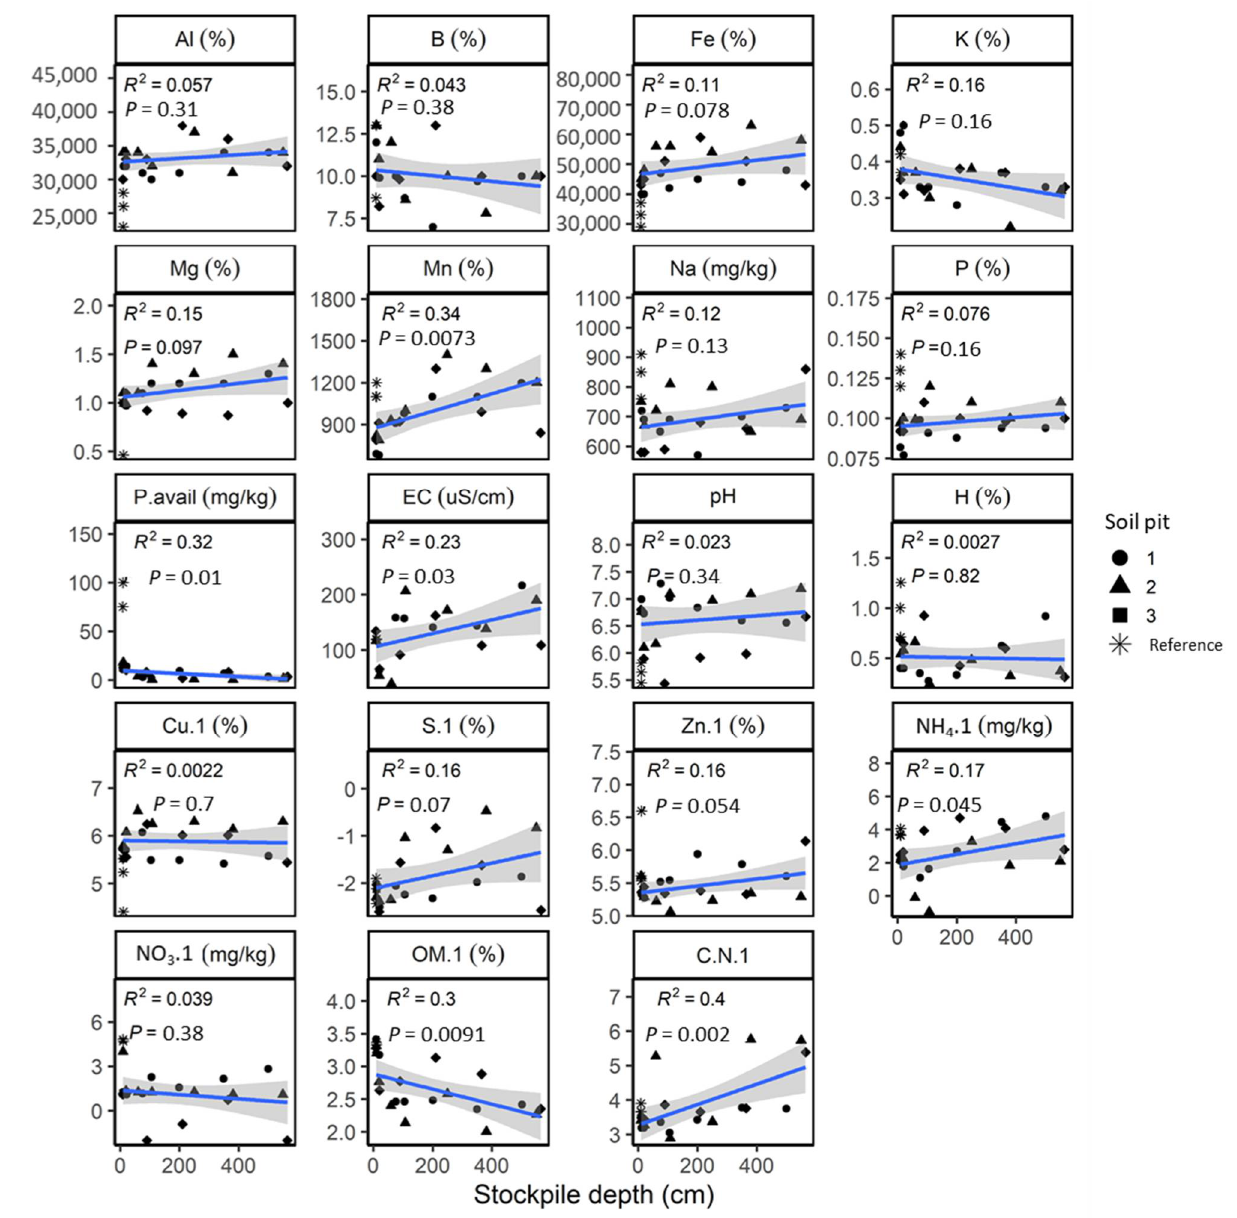
Figure 6. Linear regression plots showing changes in geochemical variables with stockpile depth at the QR mill site. The blue lines represent a linear model, and the shaded area in grey represents the 95% confidence intervals. Soil quality guidelines for agricultural land use.